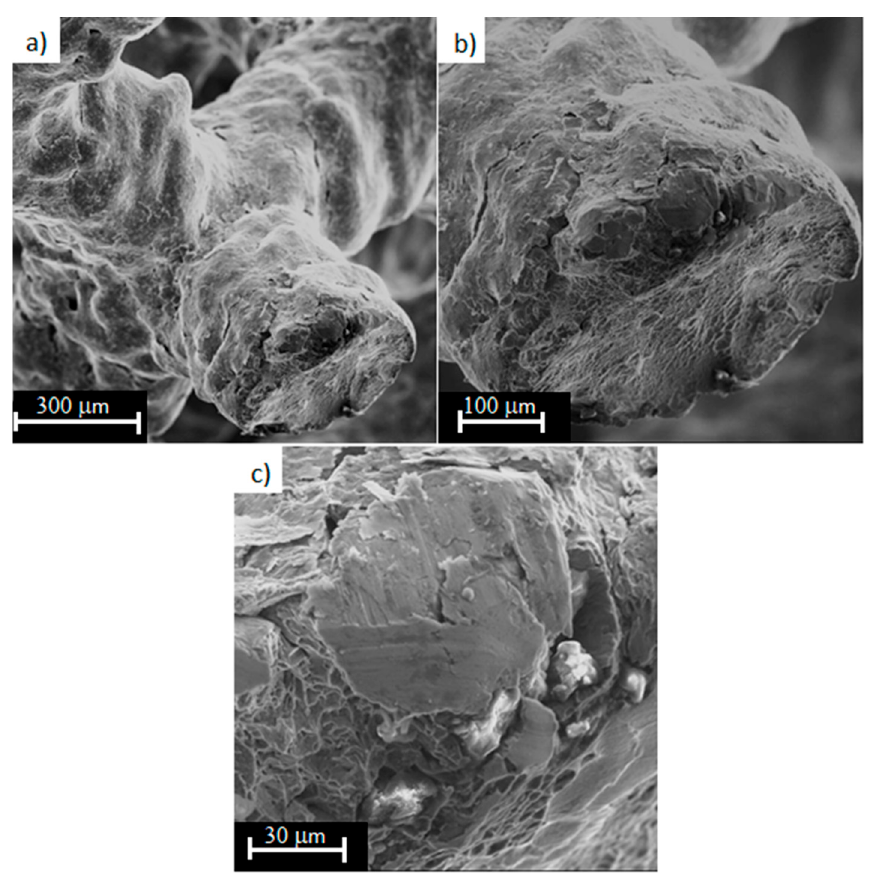
Figure 10. Fracture surfaces of Ti6Al4V titanium alloy with 81% porosity, subjected to a monotonic tensile test (magnification: ( a ) 250×; ( b ) 500×; ( c ) 2000×).